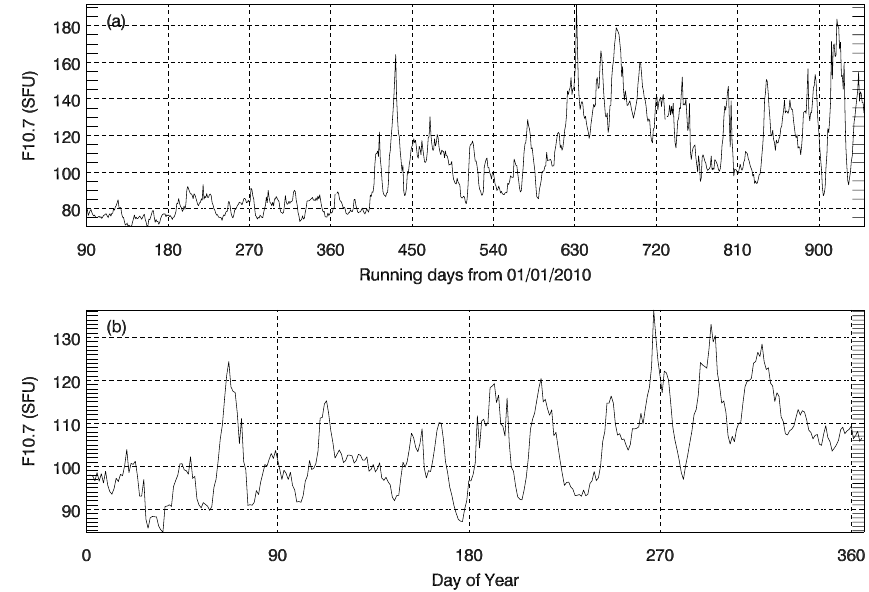
Fig. 3. Temporal evolutions of F10.7 during April 2010–July 2012 (a) and the binned F10.7 over the three years (b) .